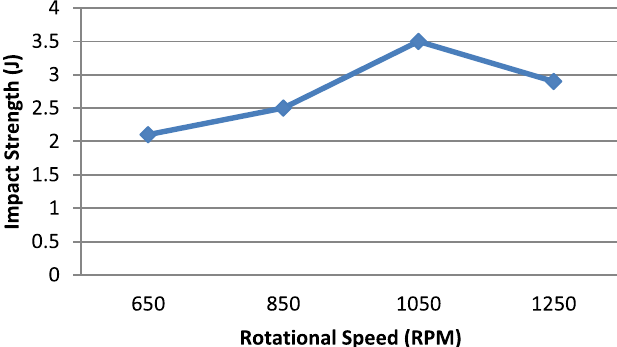
Fig. 10. Impact strength of 8 mm Tin cast tubes at speeds of 650 rpm, 850 rpm, 1050 rpm and 1250 Figure 9 indicates the tensile strength of 8 mm cast tubes at different rotational speeds. It is observable from